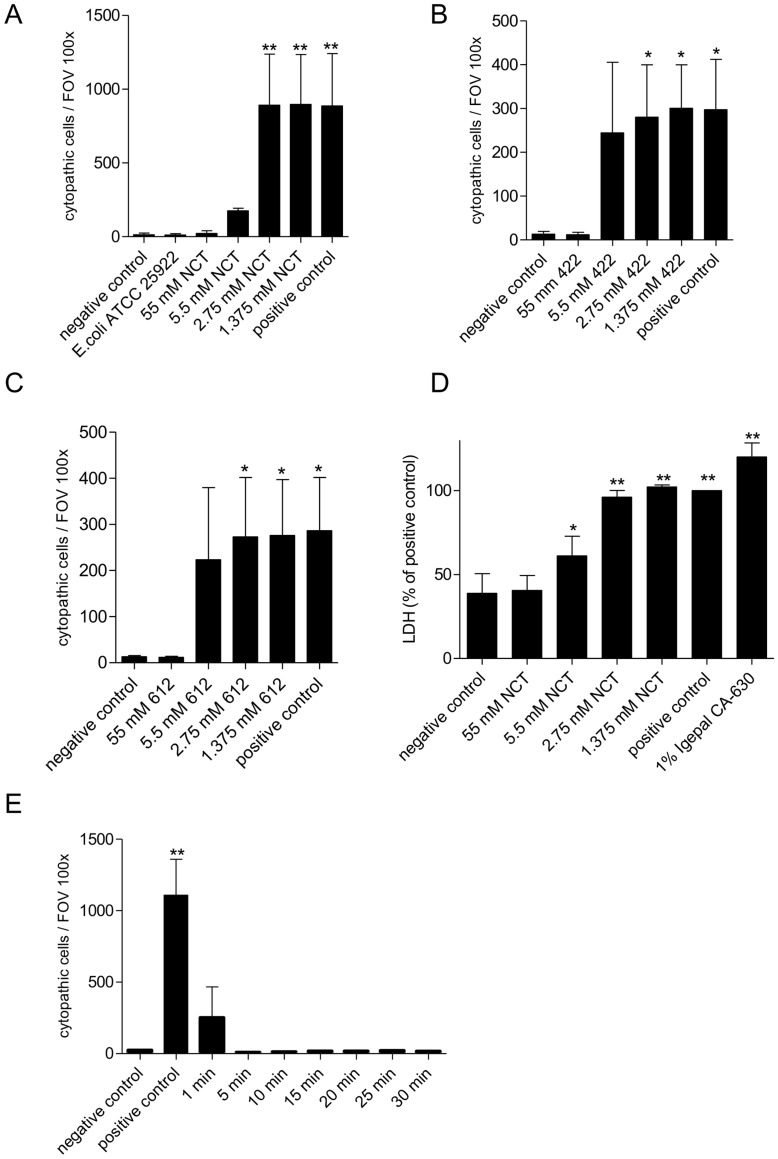
NCT, NVC-422, and NVC-612 inhibit the cytopathic effect of Stx2 in Vero cells.Supernatants of EHEC 178 cultures were treated with 1.38–55 mM of oxidants for 30 min (A–D), diluted 100-fold in RPMI + 10% v/v FCS, and added to Vero cell cultures, which were monitored for the typical cytopathic effect. (A–C) Numbers of cytopathic cells per visual field at a 100x magnification after incubation with EHEC supernatant for 72 h. Comparison of RPMI + FCS without Stx (negative control), supernatant of the non-EHEC strain ATCC 11229 (shown in A), untreated supernatant (positive control), and supernatant treated with NCT (A), NVC-422 (B), or NVC-612 (C). (D) Quantification of cell death by LDH assay after incubation with EHEC supernatant. Values were related to untreated supernatant. An additional separate positive control was performed with 1% Igepal. (E) Supernatants of EHEC 178 cultures were treated with 55 mM NCT for 1–30 min, followed by Vero cell assay and evaluation as in A–C. Mean values ± SD from three independent experiments are shown in (A–E). *P<0.05; **P<0.01.